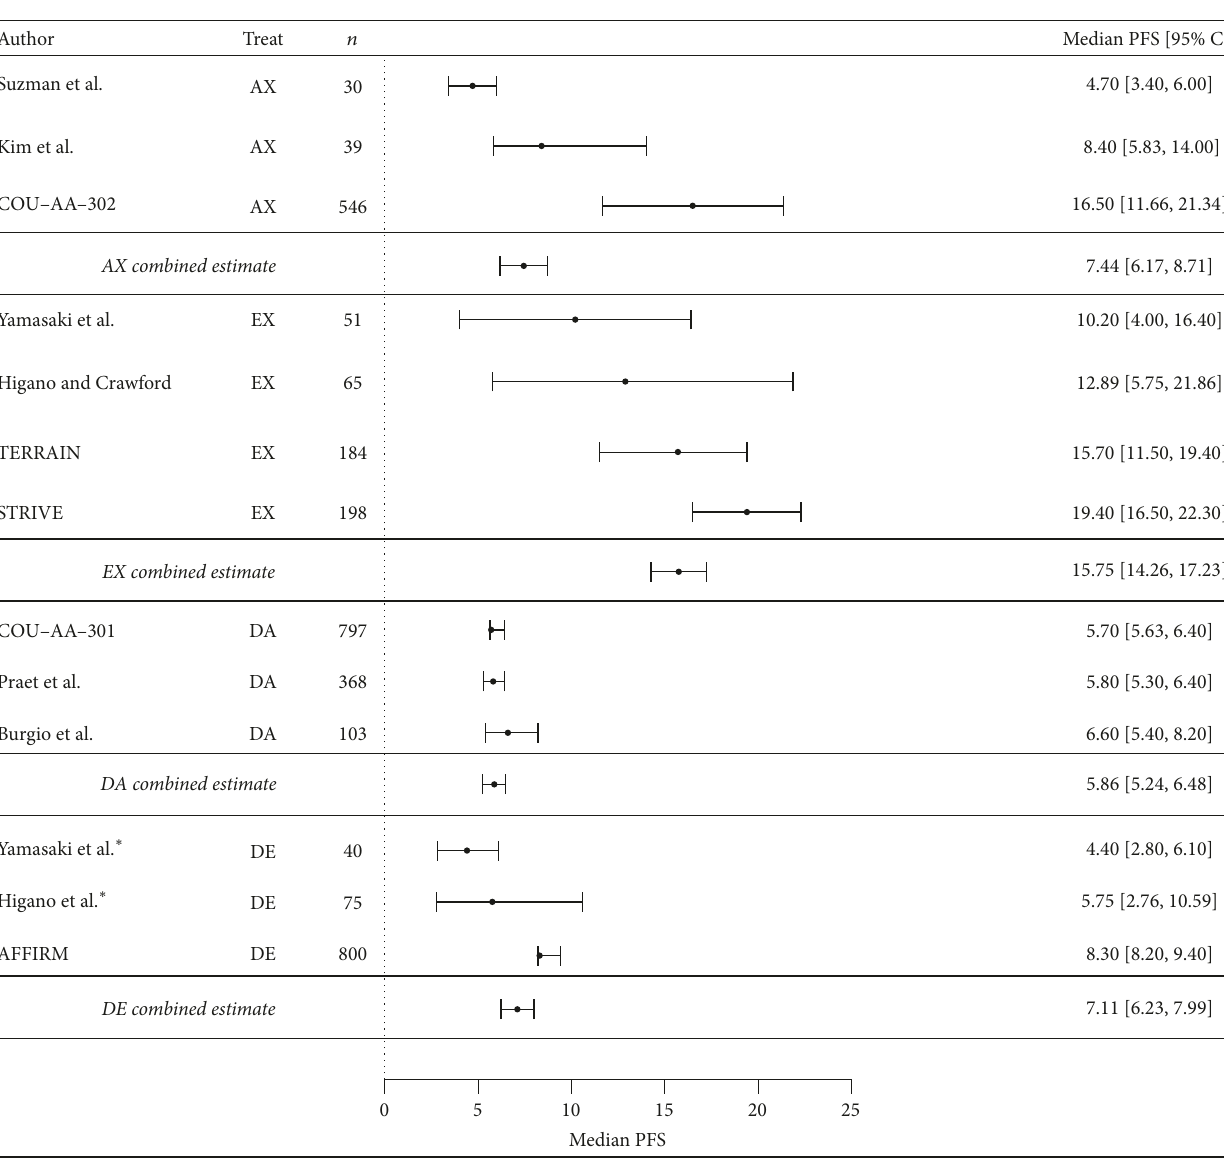
further improved to 19.5 and 14.6 months, respectively, after baseline Gleason score was taken into account. We note that the greatest median survival estimates for AX belonged to the clinical trial COU-AA-302 for both OS and PFS and that, in the case of OS, COU-AA-302 showed much longer median survival than all other studies which, we suspect, is due to the highly selective nature of clinical trial investigations. The single-center studies that decrease the combined estimate for predocetaxel abiraterone may be more reflective of real- world experiences. In the postdocetaxel setting, enzalutamide showed a small but statistically significant (especially after adjusting for baseline Gleason score) advantage over abi- raterone with respect to